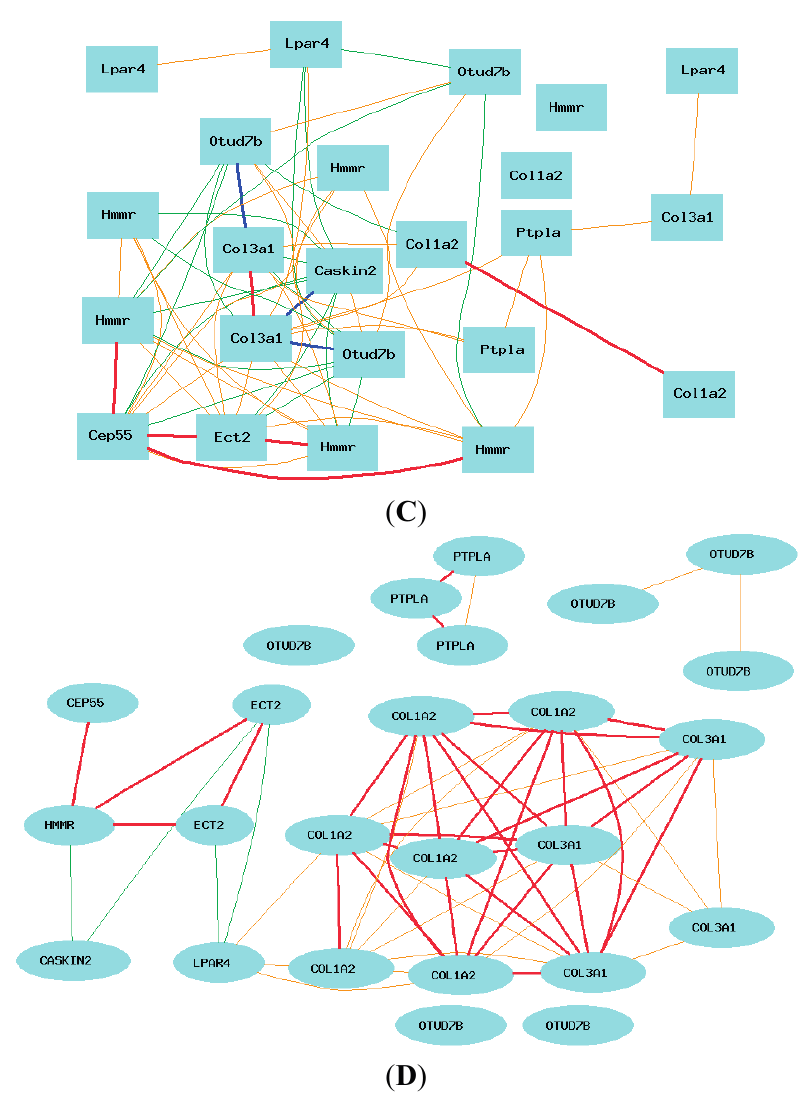
Figure 8. Summary of the gene networks of humans and mice. Each picture shows Pearson correlation coefficients greater than 0.5 or less than − 0.5. The graph’s canvas is 40.0 by 40.0 cm, and the node labels are drawn with a 16.0 point font, and the edge labels are drawn with a 16.0 point font. Solid lines represent strong correlation (absolute value: thick line = 0.7–1; thin line = 0.5–0.7), while dashed lines present weak correlation (absolute value: 0–0.5). ( A ) Summary of the network of human-positive genes in mice. The 23 nodes in the graph below show the selected genes. The 30 edges between the nodes were filtered from the 253 total edges and drawn as curves; ( B ) Summary of the network of positive genes in human microarray data. The 33 nodes in the graph below show the selected genes. All nodes are displayed. The 288 edges between the nodes were filtered from the 528 total edges and drawn as curves. The graph’s canvas is 40.0 by 40.0 cm; ( C ) Summary of network of mouse genes: the 23 nodes in the graph below show the selected genes. The 66 edges between the nodes were filtered from the 253 total edges and drawn as curves; ( D ) Summary of gene network genes from mice in human microarray data. The 25 nodes in the graph below show the selected genes. The 55 edges between the nodes were filtered from the 300 total edges and drawn as